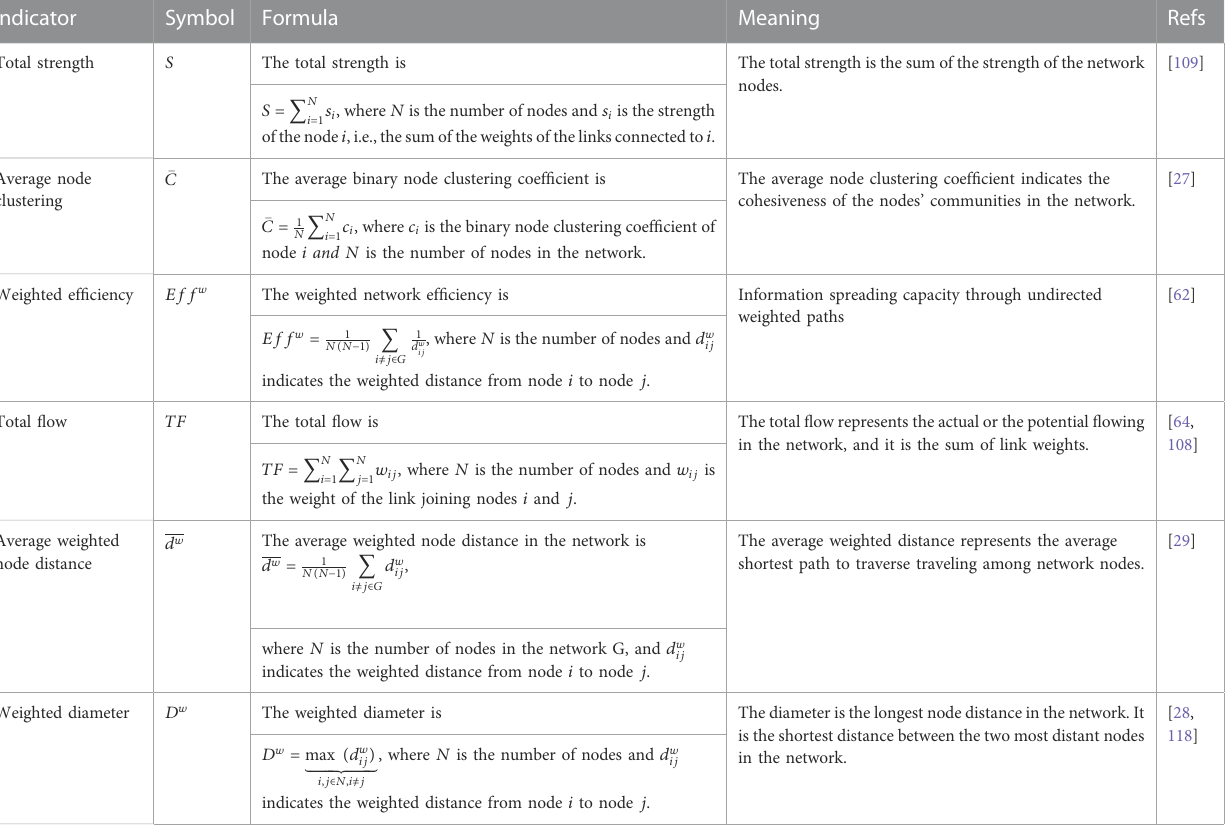
TABLE 3 List of the network functioning (robustness) indicators.